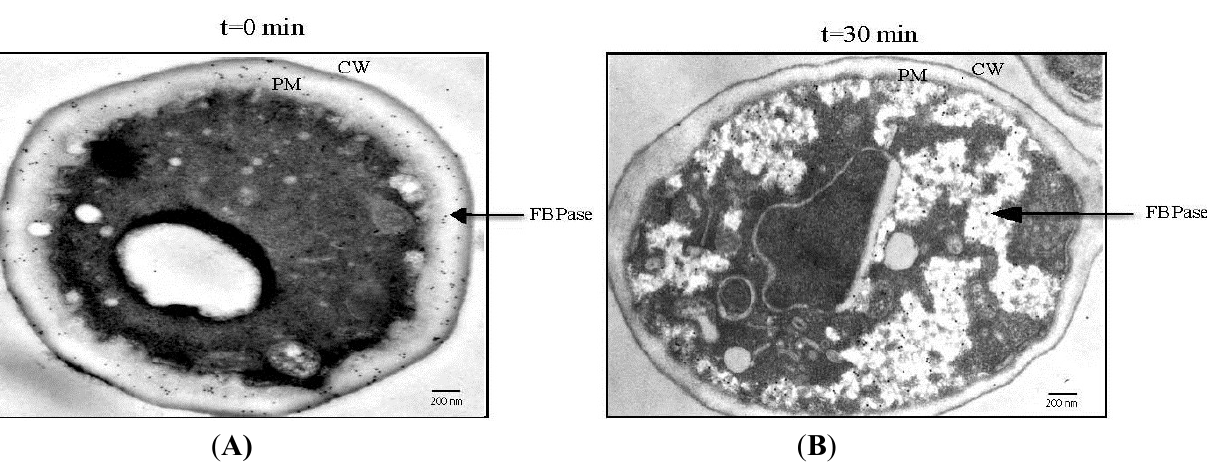
Figure 1. FBPase is re-distributed from the periplasm to the cytoplasm following glucose addition. Wild-type cells were grown in low glucose media for 3 days and harvested ( t = 0 min) ( A) ; or transferred to high glucose media for 30 min and harvested ( t = 30 min) ( B ). Cells were processed and FBPase was visualized by immuno-TEM. Bars: 200 nm, PM: plasma membrane, CW: cell wall. This figure is in a manuscript published in Proteome Science